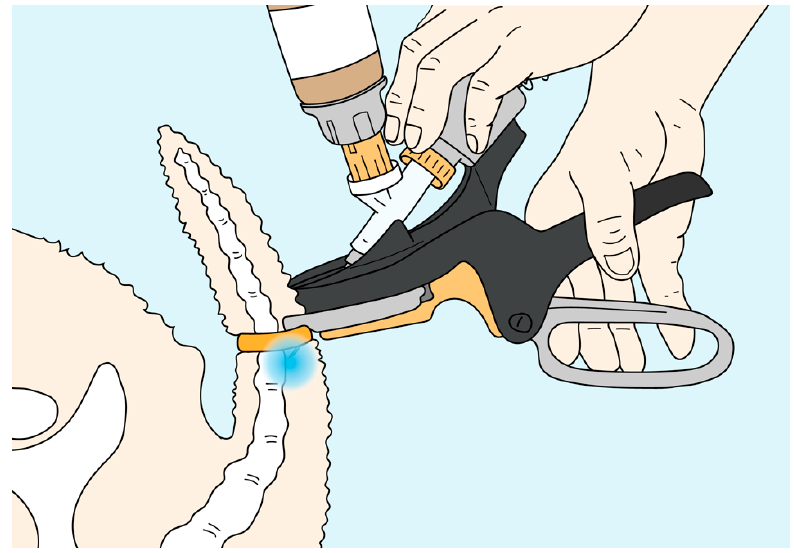
Figure 1. The protype used in the study was functionally identical to the stylized version illustrated here, which includes design modifications made to enable commercial manufacturing of the device. The diagram shows where local anesthetic is injected, proximal to the ring, when using the Numnuts ® device.